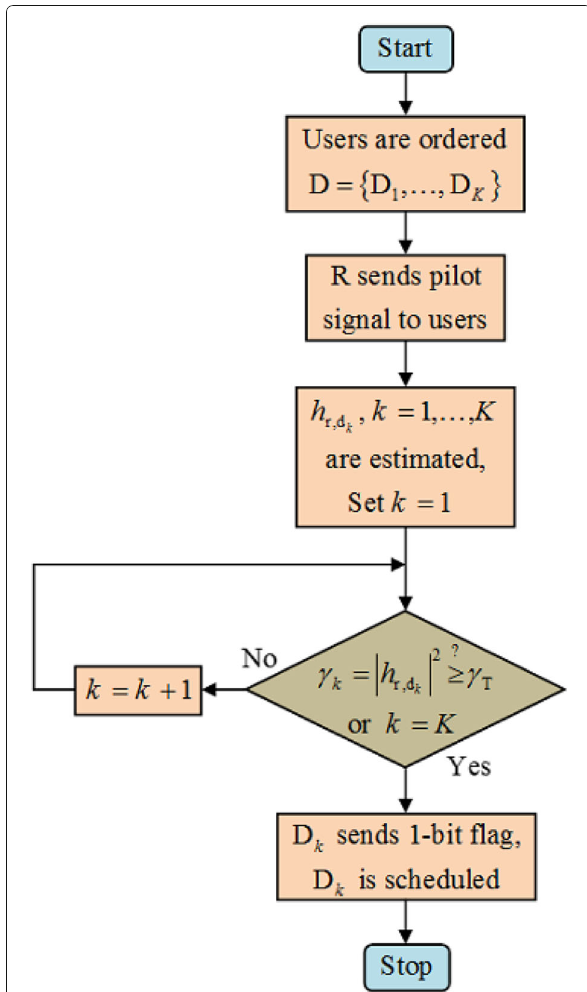
Fig. 2 Flowchart of the proposed MUSwiD user scheduling